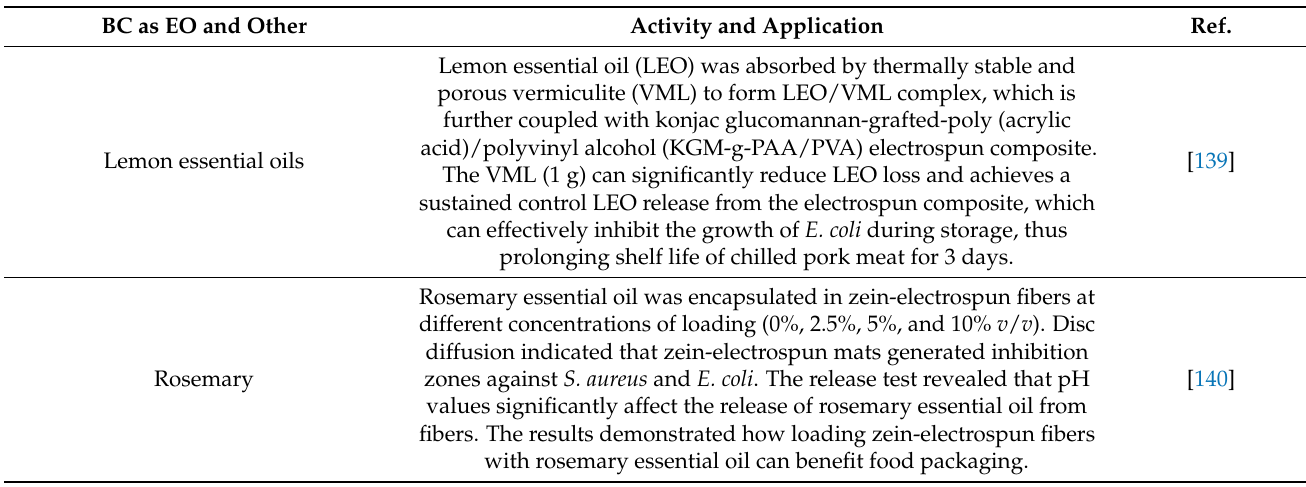
Table 2. Antimicrobial/antioxidant electrospun nanofibers with applications in food preservation. BC as EO and